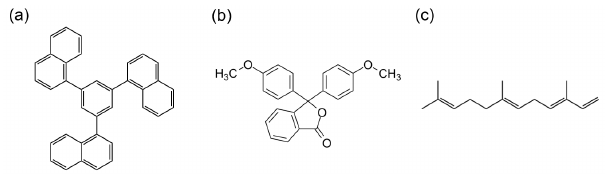
Figure 1. Chemical structures of (a) 1,3,5-tris(1-naphthyl)benzene, (b) phenolphthalein dimethyl ether, and (c)